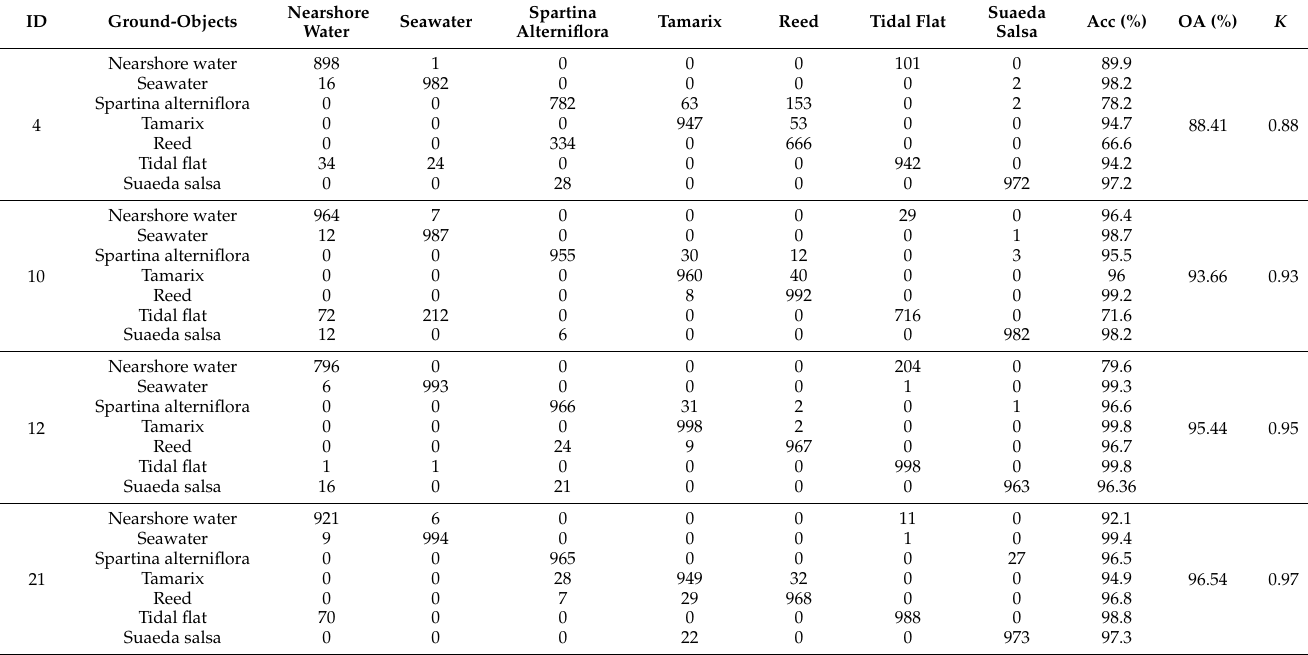
Table 4. Confusion matrixes of the four schemes on AlexNet.